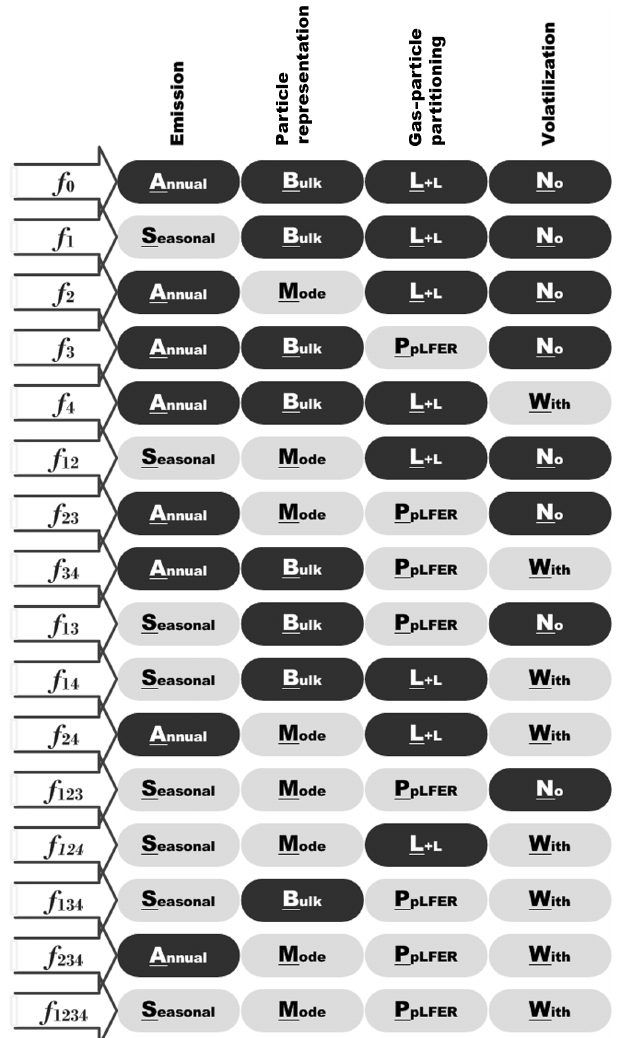
Figure 3. List of experiments performed for the factor separation analysis to study sensitivity to temporal variation in emission and process parameterizations (particulate-phase representation, gas– particle partitioning scheme, and volatilization); L+L: Lohmann– Lammel; PpLFER: poly-parameter linear free-energy relationships.